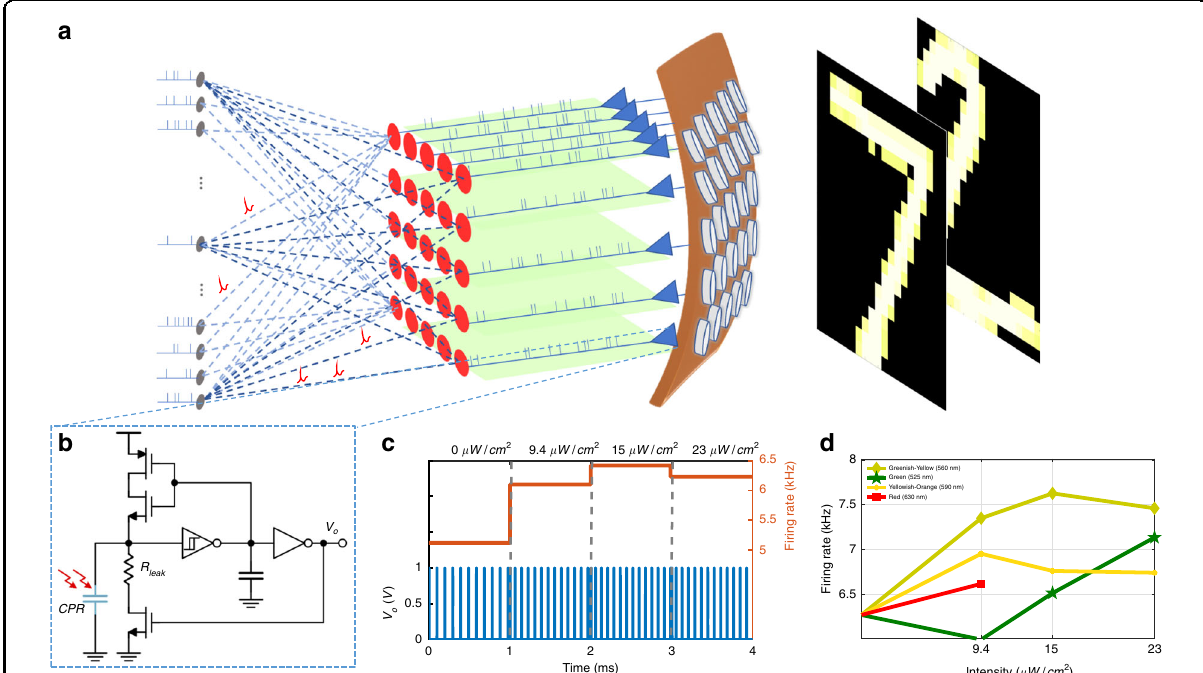
Fig. 7 Neuronal interfacing and output response. a Spiking neural network processing the spike train, generated after seeing handwritten digits, b the schematic of low power CMOS circuit designed to interface with the CPR to generate the spike train. c The output spike train under greenish- yellow light and different illumination intensities, and d the fi ring rate under different light intensities and